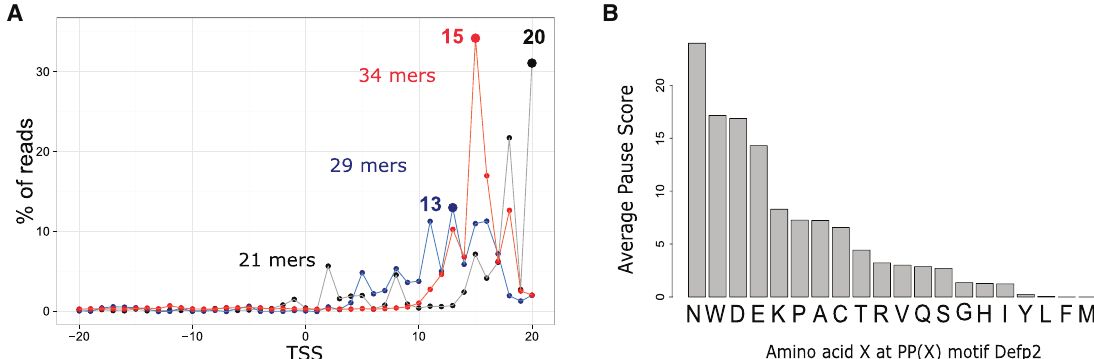
Figure 4. A , Sample Δ Efp2: per�entage of read 3�� end �overage 20 nu�leotides around the TSS�� Three mat�h sizes are represented: 21, 29 and 34 mers�� B , Barplot of the average ribosome o��upan�y on PP(X) motifs in the Δ Efp2 sample, where X is any of the 20 possible amino